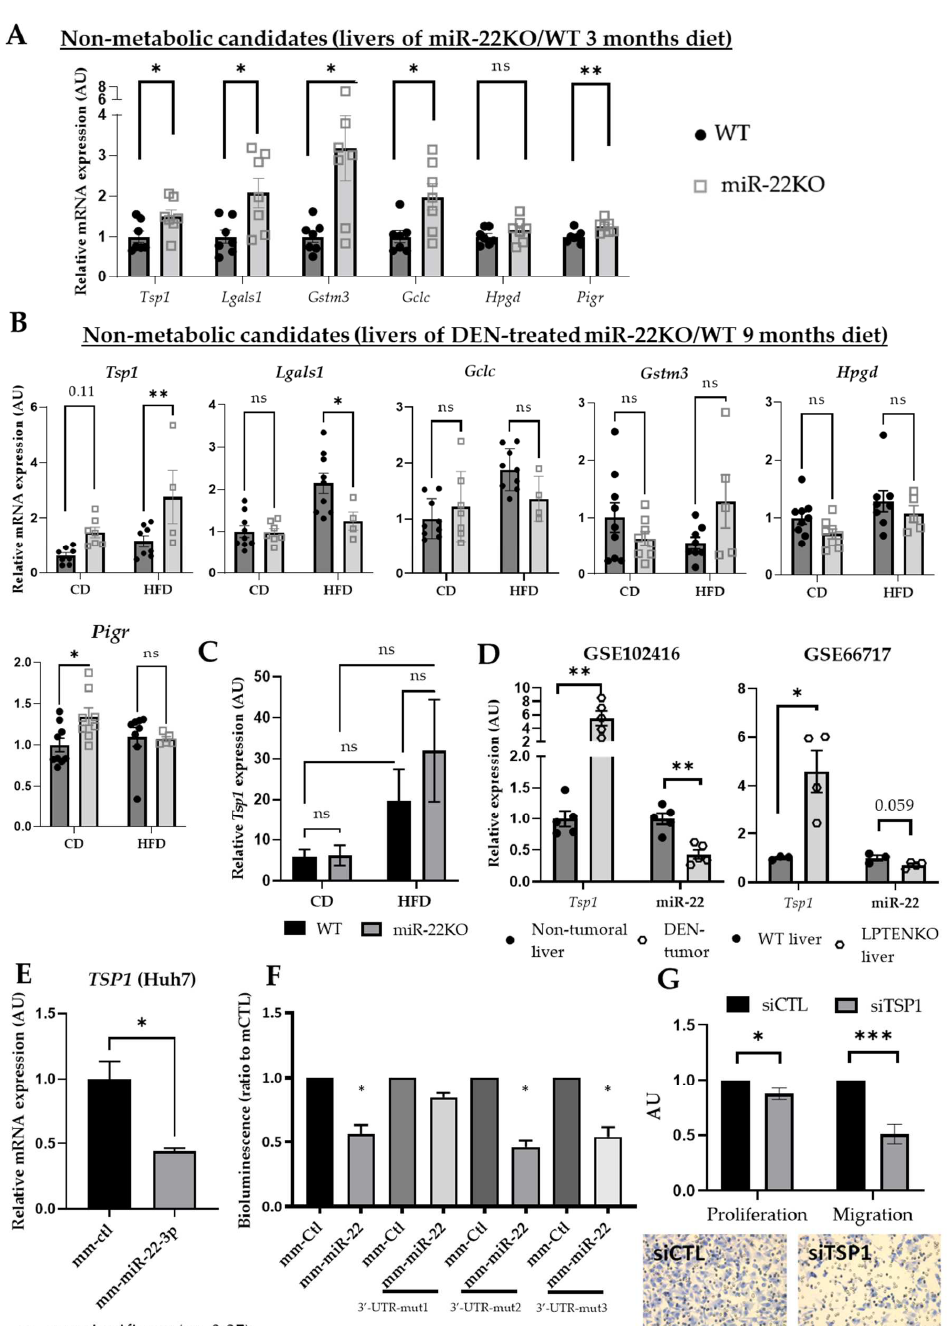
Figure 6. MiR-22 regulates cancer hallmarks through non-metabolic target genes. RT-qPCR analysis of mRNA expression of Tsp1 , Lgals1 , Gstm3 , Gclc , Hpgd , and Pigr in ( A ) the livers of miR-22KO and WT mice under HFD for 3 months (diet began at 2 months of age, n = 7 mice/group) and ( B ) the livers of DEN-treated miR-22KO and WT mice under CD or HFD for 9 months (diet began at 2 months of age, n = 4–9 mice/group). ( C ) Tsp1 mRNA expression in the tumor samples obtained from DEN-treated miR-22KO and WT mice under CD or HFD for 9 months ( n = 4–10 tumors/group). ( D ) Relative Tsp1 and miR-22 expression levels in GEO datasets GSE102416 ( n = 5/group) and GSE 66,717 ( n = 3–4/group). ( E ) RT-qPCR analysis of mRNA expression of TSP1 in Huh7 cells transfected with 20 nM of miR-22-3p- mimicking oligonucleotides (mm-miR-22-3p) or control oligonucleotides (mm-ctl), 48 h post-transfection ( n = 3). ( F ) Inhibition of the luciferase activity of pLightSwitch-3UTR-TSP1, bearing or not mutations (Mut1, Mut2, or Mut3) in each predicted seed sequence for miR-22, in HepG2 cells treated with